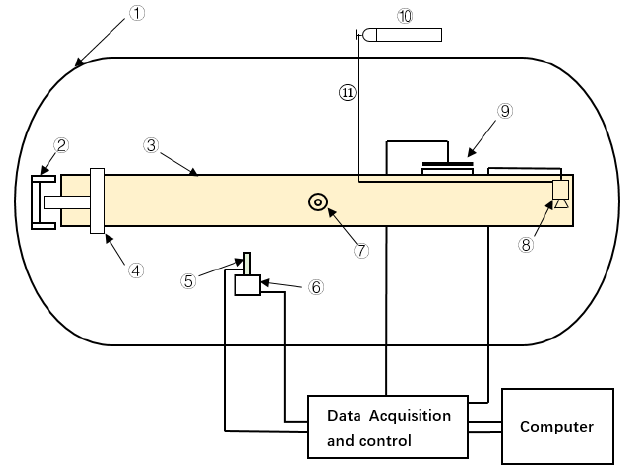
Figure 5. Schematic diagram of measuring system. 1 (cid:13) Vacuum Chamber; 2 (cid:13) Damper; 3 (cid:13) Pendulum; 4 (cid:13) Counter-weight; 5 (cid:13) Displacement Device; 6 (cid:13) Precision Seat; 7 (cid:13) Axis; 8 (cid:13) Micro-thruster; 9 (cid:13) Calibration System; 10 (cid:13) Gas Bottle; 11 (cid:13) Pipe.